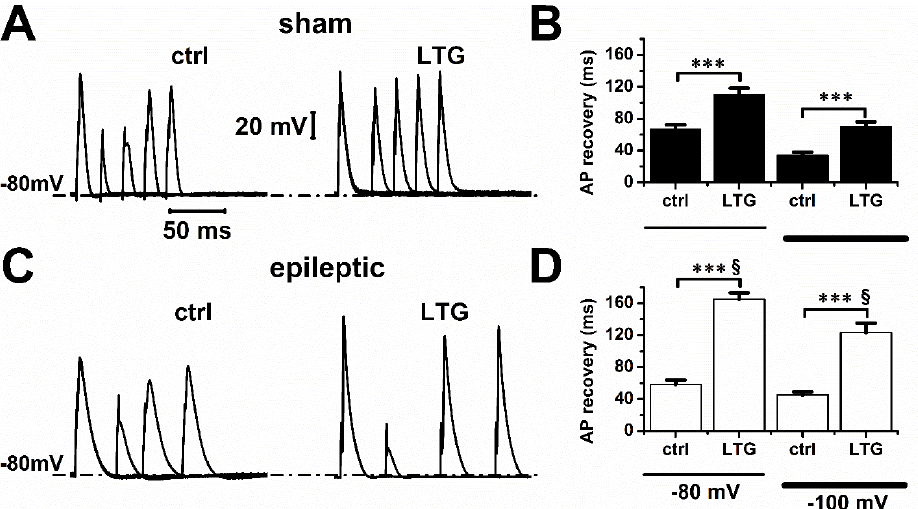
Figure 5. LTG prolonged cardiac action potential refractory period. ( A , C ) Representative action potential recordings from sham and epileptic rats in control (ctrl) and in presence of 1 µ mol/L of LTG. Cardiomyocytes were held at membrane potentials of −80 or −100 mV and stimulated at a pacing cycle length of 2 ms (sham) and 10 ms (epileptic) for control experiments, and 5 ms (sham) and 50 ms (epileptic) to 1 µ mol/L of LTG. For simplicity, only representative records of cells held at − 80 mV are shown in the figure. However, as indicated above, the recordings were also performed on the same cell at −100 mV. ( B , D ) Action potential (AP) recovery time was measured as the time needed to recover a full amplitude action potential. Each bar represents the average value (±SEM). Tukey test using one-way ANOVA (ctrl vs. LTG), *** indicates p ˂ 0.001, and § indicates p ˂ 0.001 (sham vs. epileptic). Number of animals: 3/group (ctrl and LTG). Number of cells: Sham (ctrl, LTG):14, 14; Epileptic (ctrl, LTG): 14, 12.